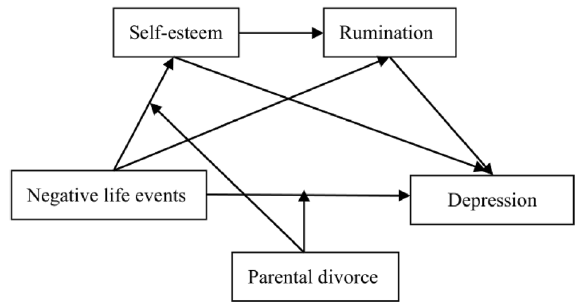
Figure 1. The proposed moderated mediation